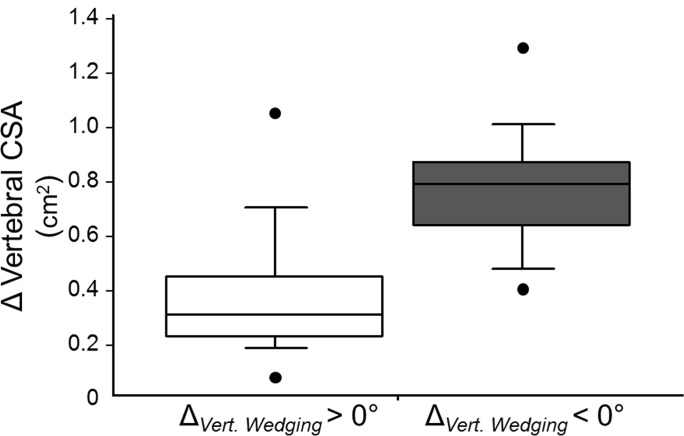
Boxplot showing differences in vertebral cross-sectional growth between girls with increased (n = 14) and decreased vertebral body wedging (n = 13); p = 0.001.